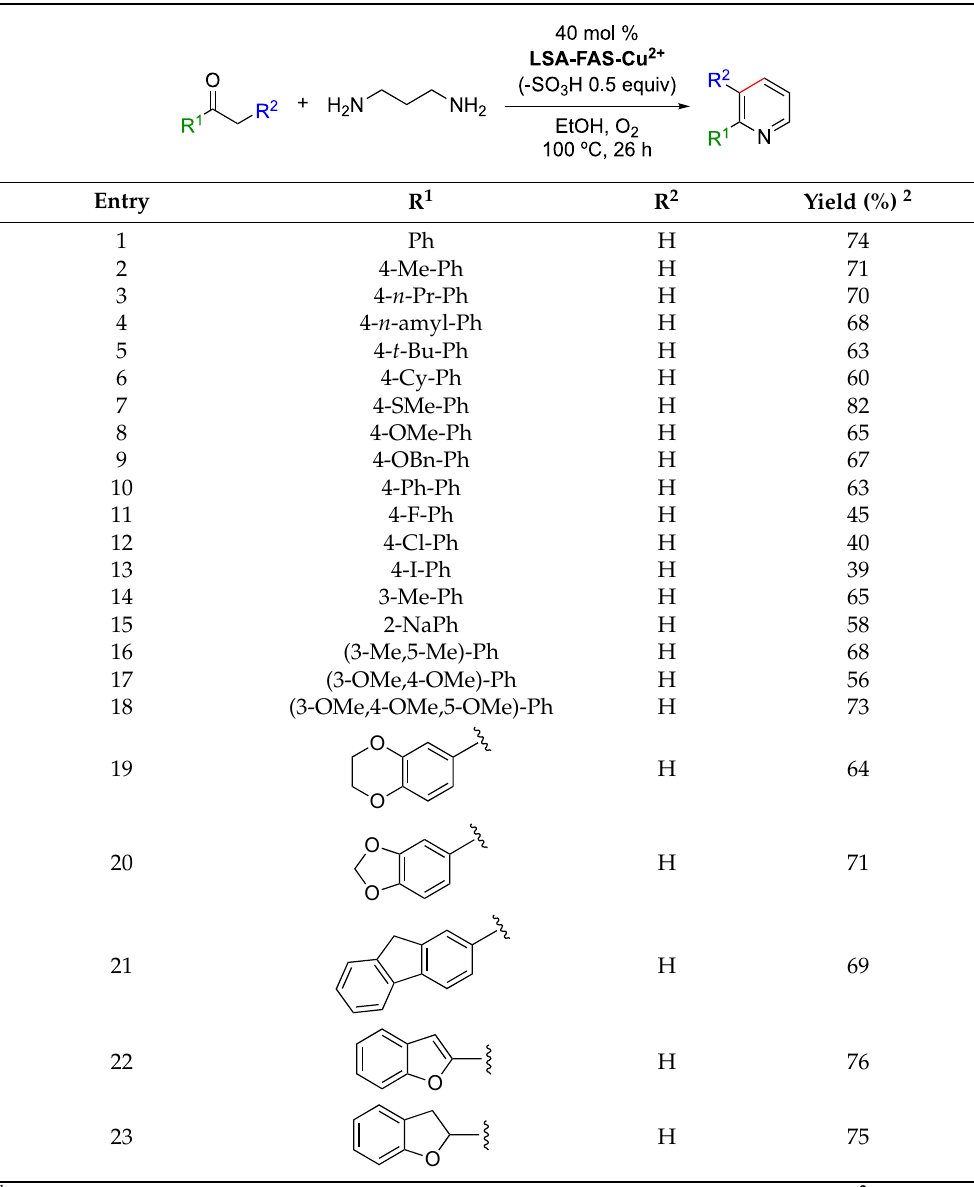
Table 5. LSA-FAS-Cu 2+ catalyzed the reaction of acetophenones and 1,3-diaminopropane, a ff ording 2-arylpyridine derivatives [34] 1 .